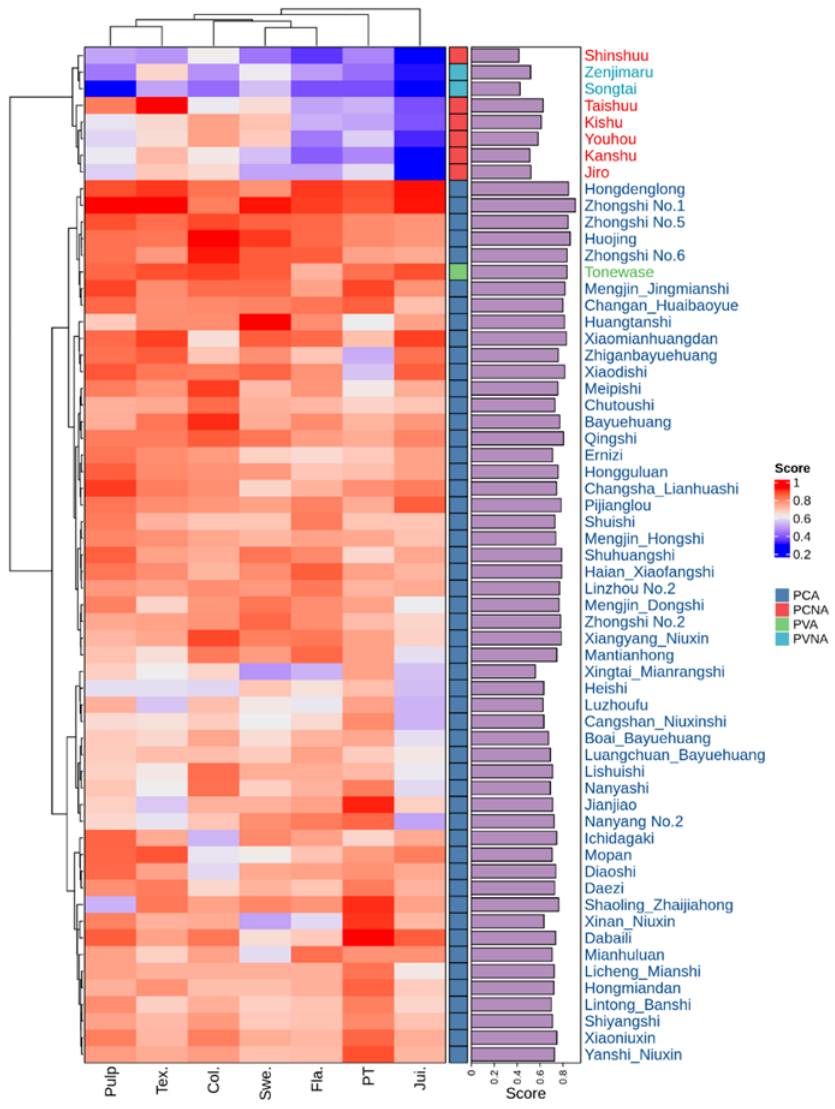
Figure 5. The synthetic “Reasonable − satisfaction” scores and cluster analysis of sensory quality evaluation with different cultivars of persimmon fruit . Note: Pulp: Pulp; Tex.: Texture; Col.: Color; Swe.: Sweet; Fla.: Flavor; PT: Pericarp thickness; Jui.: Juice.